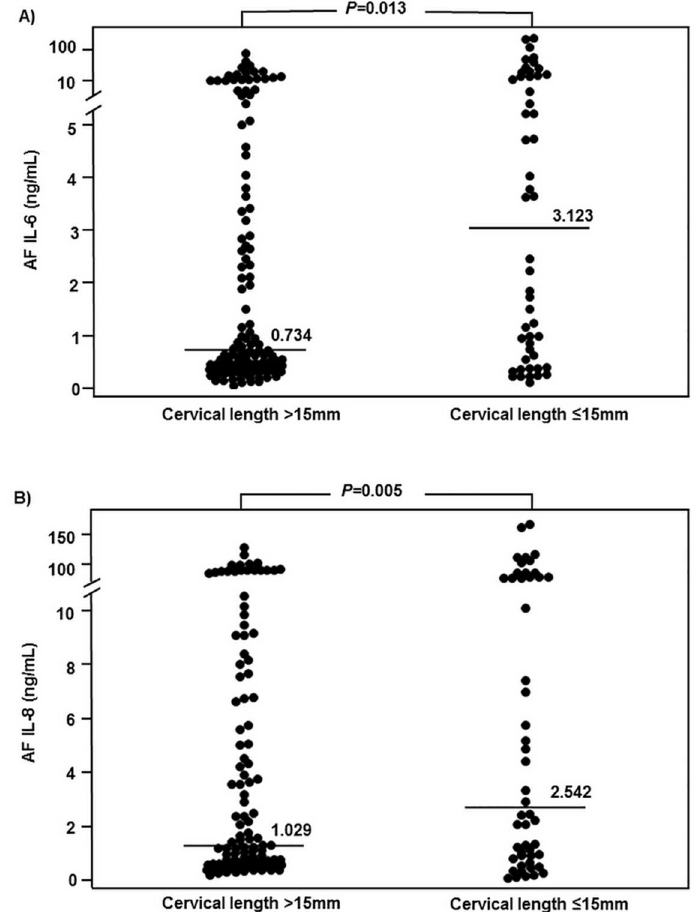
Fig 2. Amniotic Fluid (AF) Interleukin-6 (IL-6) and AF IL-8 concentrations of the study population according to the presenceor absence of a short cervix (AF IL-6: Median 3.123 ng/ml, interquartile range 0.569 to 16.181 ng/ml vs. median 0.734 ng/ml, interquartile range 0.378 to 4.096 ng/ml, P = 0.013; AF IL-8: Median 2.542 ng/ml, interquartile range 0.935 to 14.407 ng/ml vs. median 1.029 ng/ml, interquartile range 0.389 to 6.509 ng/ml, P = 0.005; respectively).